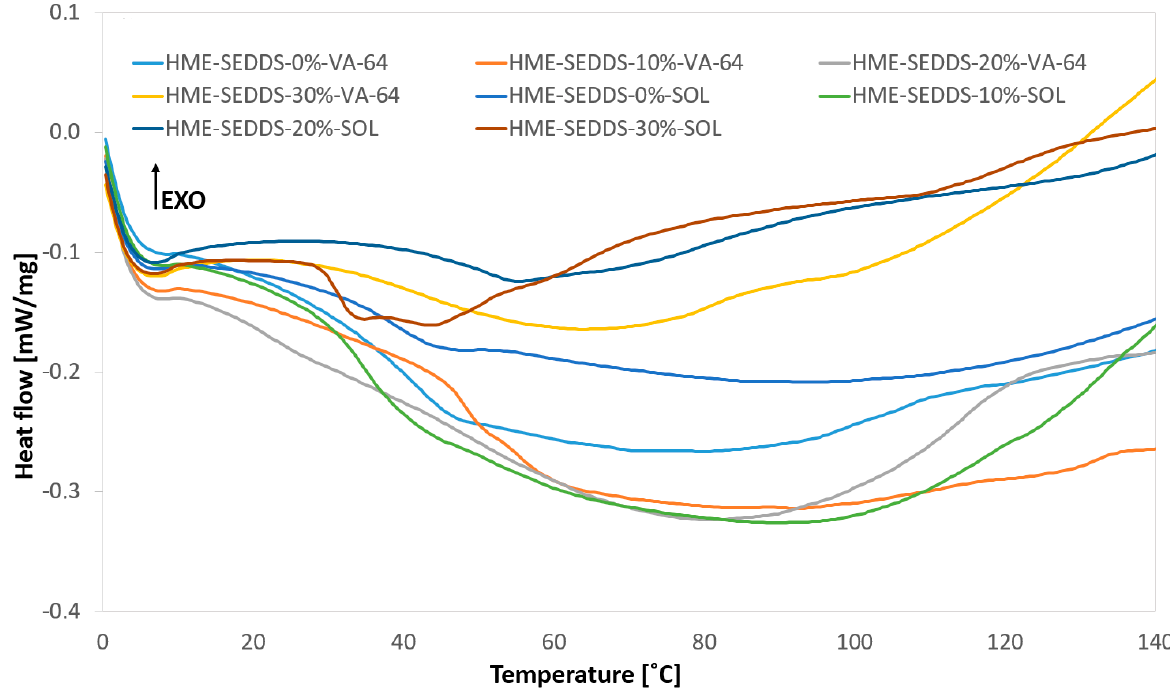
Figure 4. DSC thermograms of HME–SEDDSs.